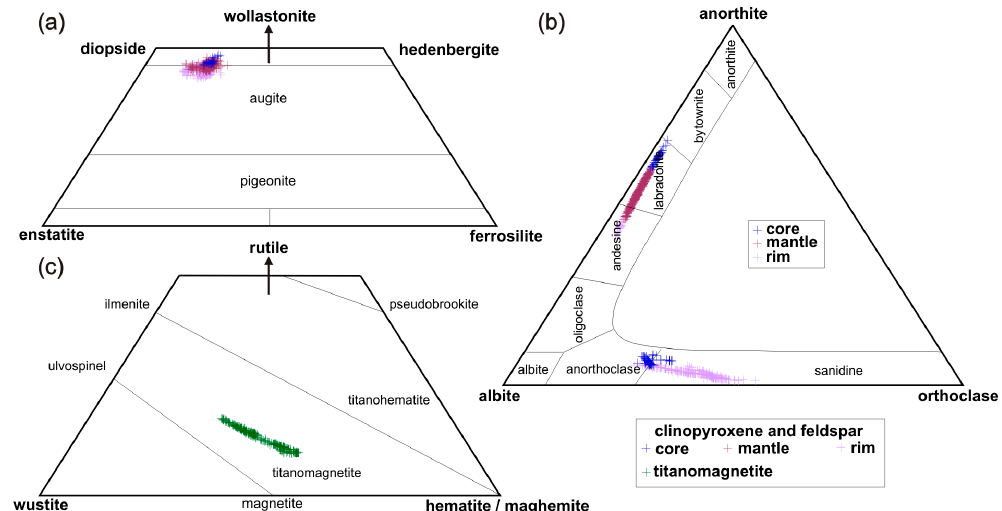
Figure 3. Classification diagrams used for clinopyroxene ( a ), feldspar ( b ) and titanomagnetite ( c ). The site occupancies, molecular components, and Fe 3+ /Fe 2+ ratios of clinopyroxene have been calculated on the basis of six oxygen atoms following References [38,39], whereas the classification scheme adopted comes from Reference [40]. The stoichiometry and composition of magnetite (Mt)- ulvospinel (Usp) solid solution has been recalculated following Reference [55].